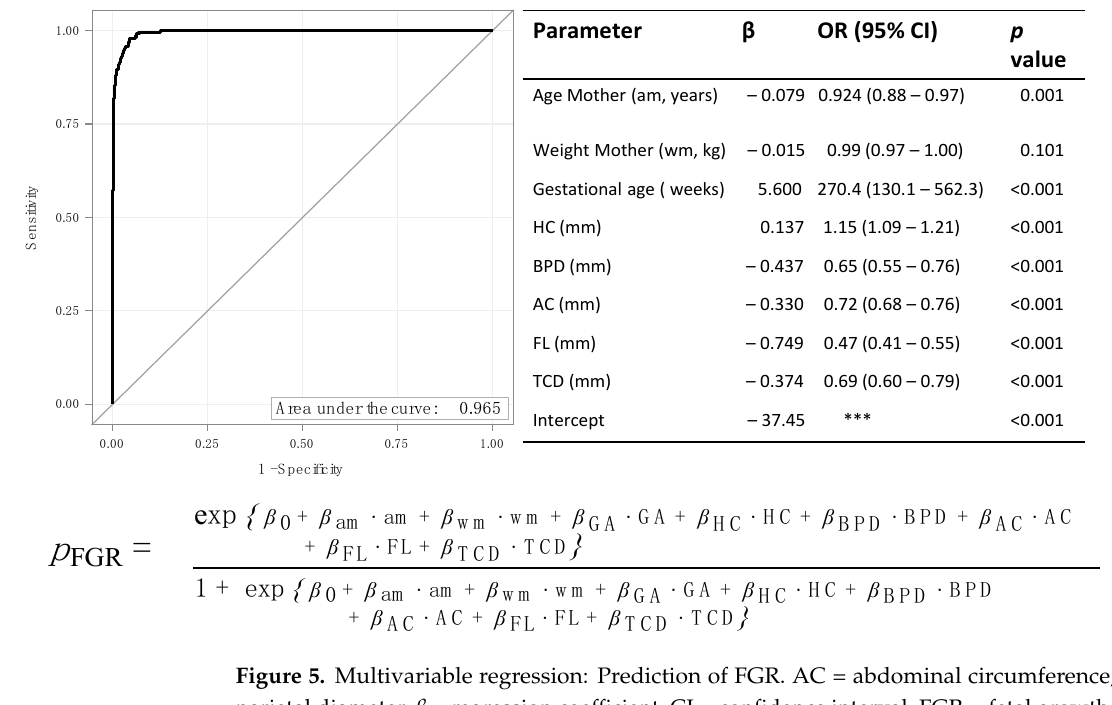
Figure 5. Multivariable regression: Prediction of FGR. AC = abdominal circumference, BPD = biparietal diameter, ß = regression coefficient, CI = confidence interval, FGR = fetal growth restriction, FL = femur length, HC = head circumference, OR = odds ratio, TCD = transcerebellar diameter. *** CI not given